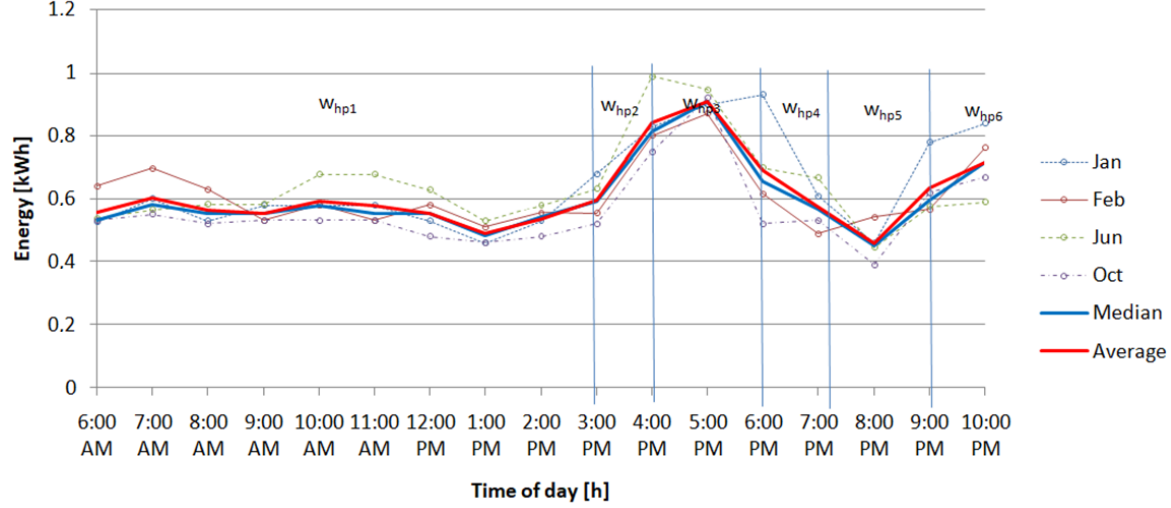
Figure 3. Energy consumption for trip between stops in both directions (up and down).